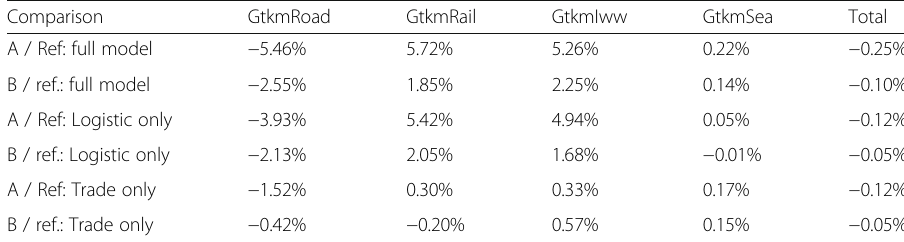
Table 7 Results for kilometre-based truck tolls by transport modes and model Comparison